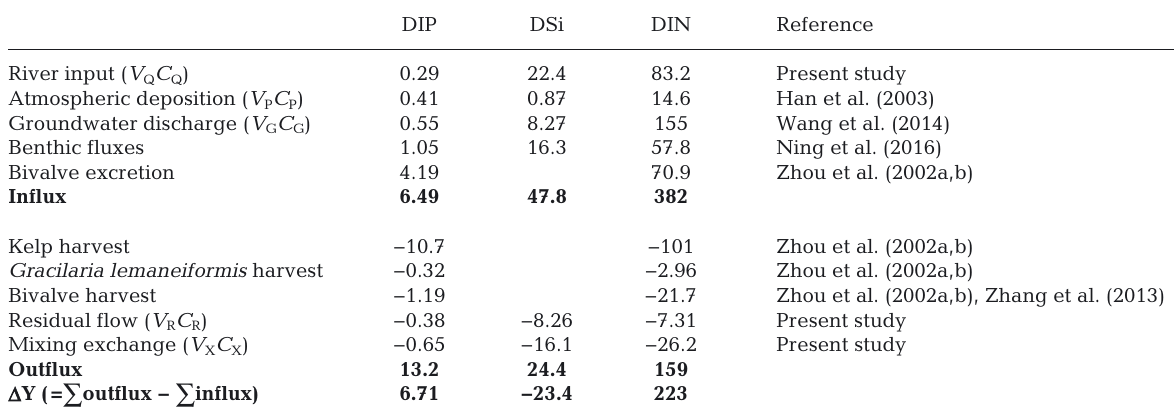
Table 3. Nutrient budgets for Sanggou Bay, China. V R C R : residual nutrient transport out of the system of interest (Eq. 1); V X C X : mixing exchange flux of nutrients (Eq. 2); influx (outflux): total nutrient flux into (out of) the system of interest. Δ (= ∑ outflux − ∑ influx) is the non-conservative flux of nutrients. Negative and positive signs of Δ indicate that the system is a sink or a source, respectively. DIP (DIN): dissolved inorganic phosphorus (nitrogen), DSi: dissolved silicate (units: 10 6 mol)